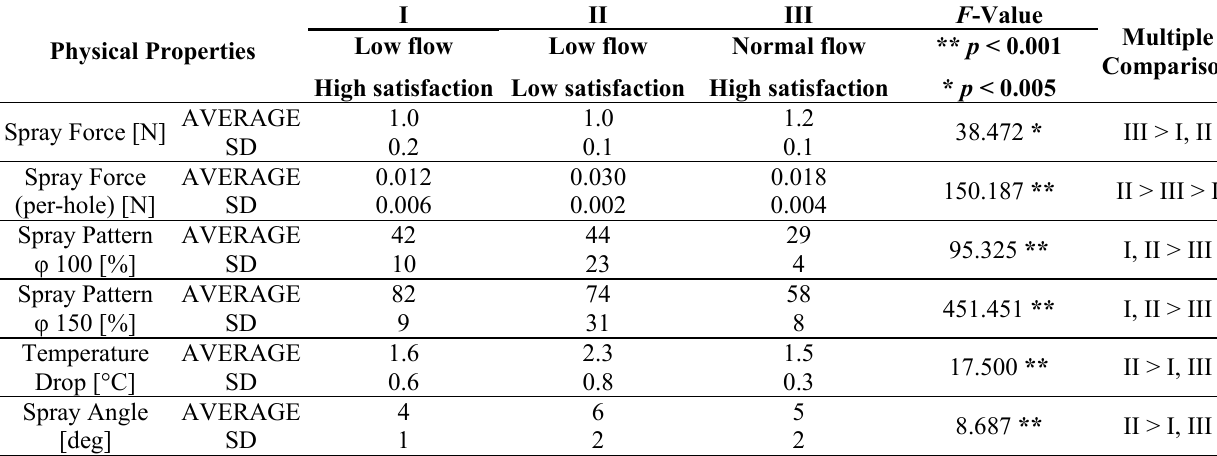
Table 2. Result of ANOVA and multiple comparisons